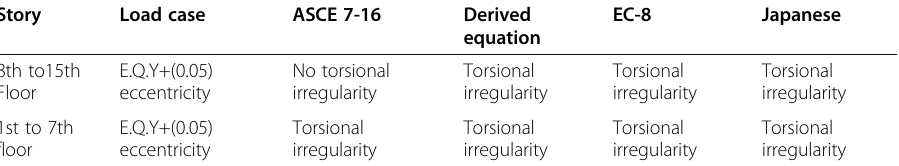
Table 11 Torsional irregularity check of 2nd model due to ASCE 7-16, EC-8, Japanese, and derived